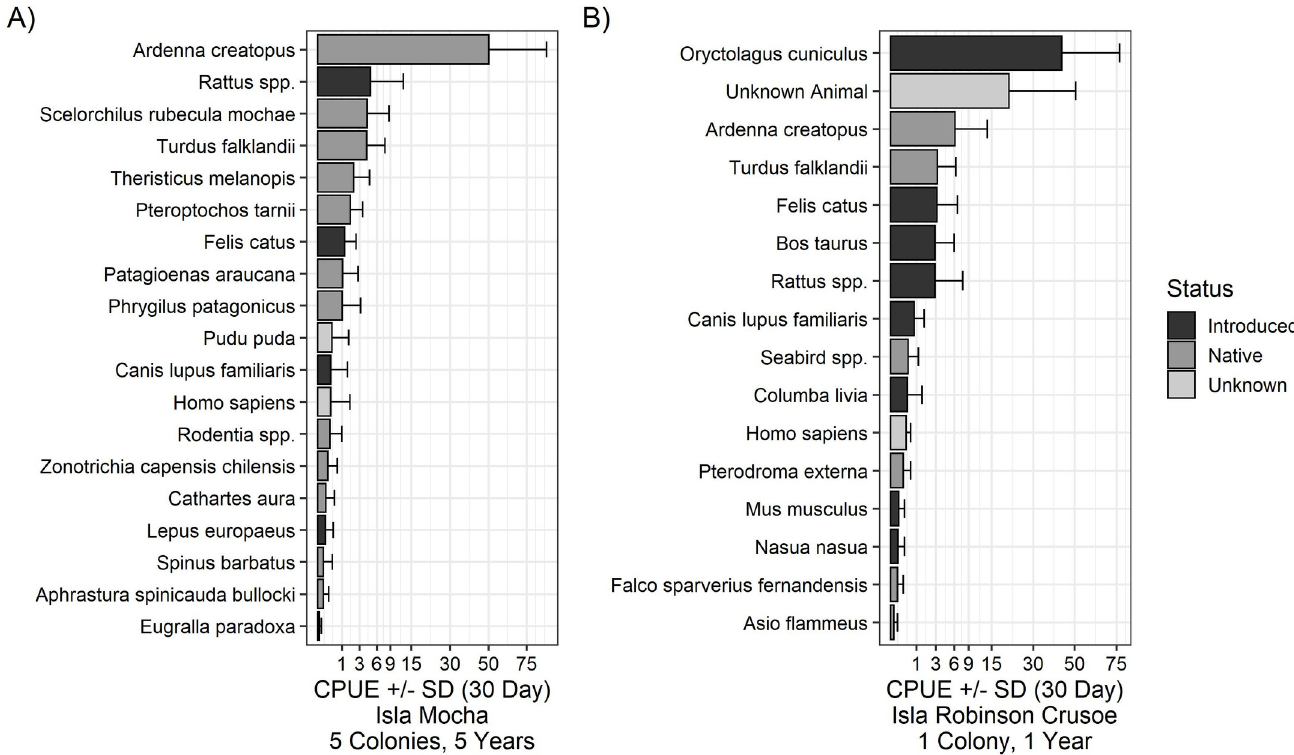
Fig 1. Mean 30-day catch per unit effort (CPUE) ± SD for each species on Isla Mocha (A) and Isla Robinson Crusoe (B), Chile. Mean 30-day CPUE was calculated as the mean hourly CPUE and multiplied by 720 (24 hours � 30 days). The x-axis is a square root scale. Species CPUE values are comparable within islands but not across islands because study methodology and duration differed on each island. Five breeding colonies were monitored from 2015–2020 on Isla Mocha and one breeding colony was monitored from 2019–2020 on Isla Robinson Crusoe.